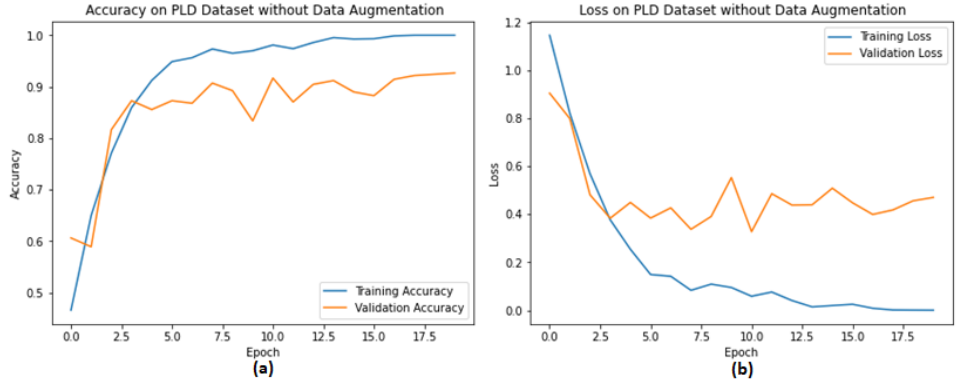
Figure 11. ( a ) Accuracy graph of PDDCNN on PLD without data augmentation. ( b ) Loss graph of PDDCNN on PLD without data